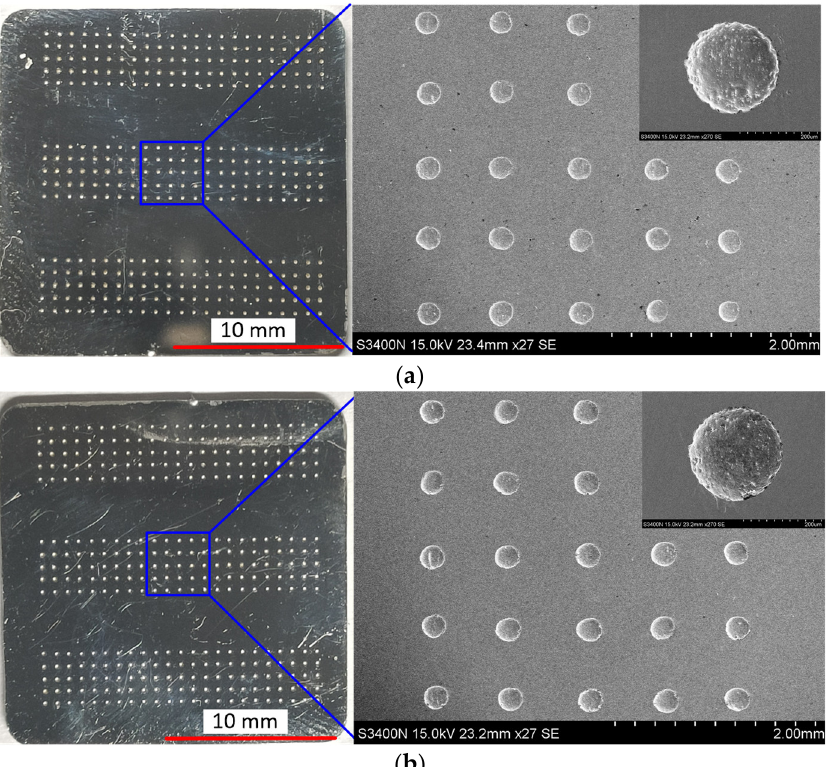
Figure 16. Micro dimples generated on two workpieces at one time with the optimized parameters. ( a ) Workpiece 1; ( b ) Workpiece 2.